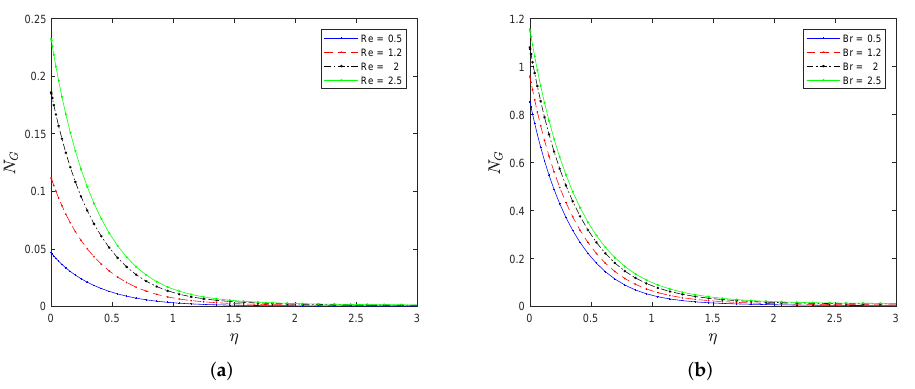
Figure 7. The influences of ( a ) the local Reynolds and ( b ) Brinkman numbers on the entropy genera- tion profiles.